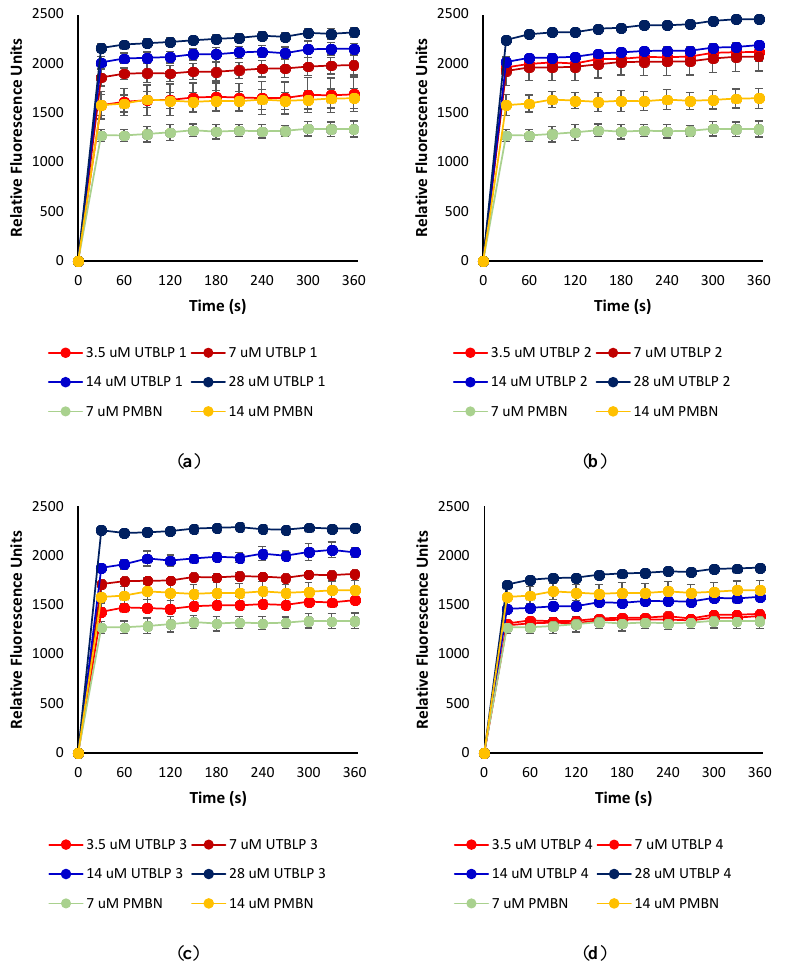
Figure 4. Dose-dependent increase in fluorescence of NPN in the presence of ( a ) UTBLP 1 , ( b ) UTBLP 2 , ( c ) UTBLP 3 , ( d ) UTBLP 4 , and PMBN (control) in A. baumannii ATCC 17978.